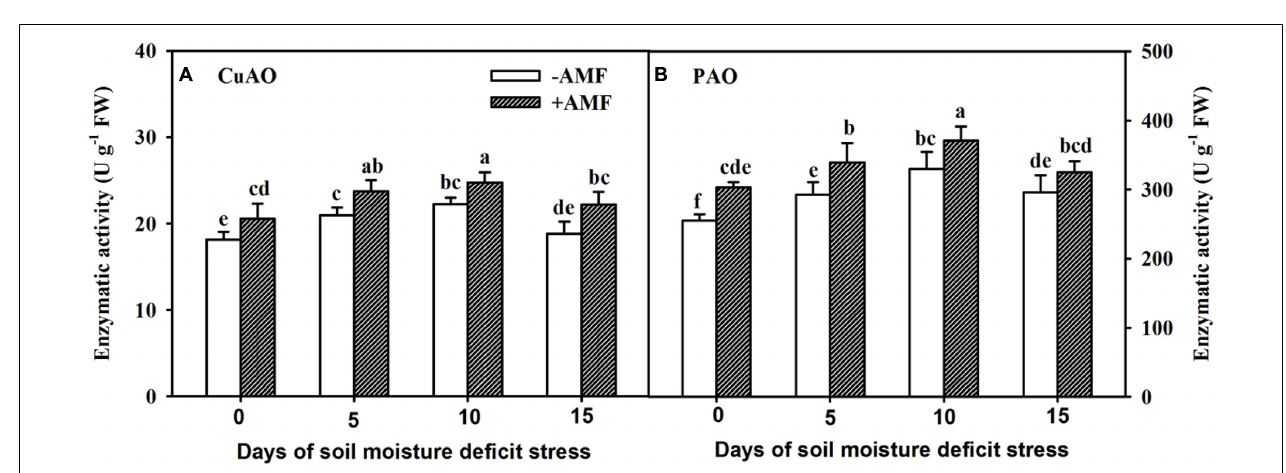
FIGURE 6 | Activities of root arginine decarboxylase (ADC) (A) , ornithine decarboxylase (ODC) (B) , spermidine synthases (SPDS) (C) , and spermine synthases (SPMS) (D) of trifoliate orange seedlings inoculated with and without Funneliformis mosseae during exposure to soil moisture deficit stress (SMDS) of 0-15 days. Data (mean ± SD, n = 4) followed by different letters above the bars indicate significant ( P < 0.05) differences.